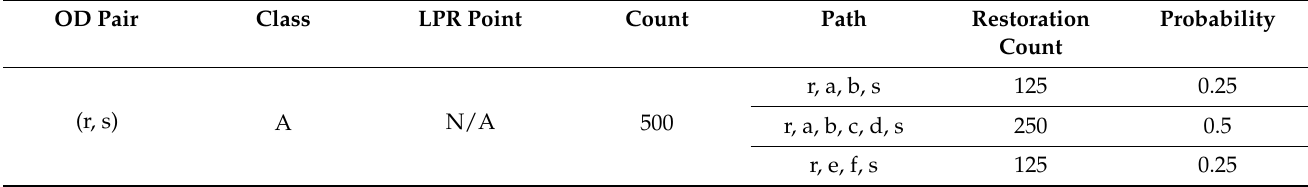
Table 4. One dataset of probability generation of the OD pair ( r, s ).